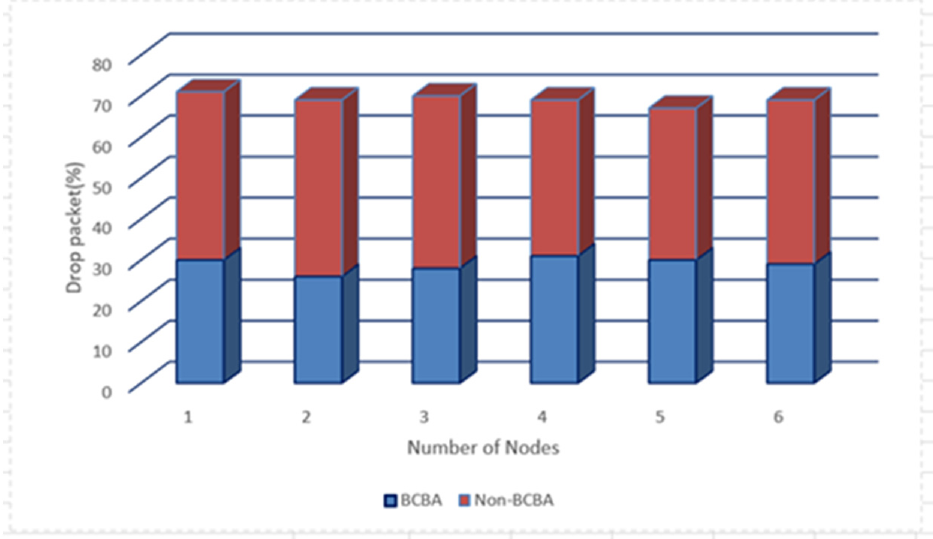
Figure 9. Packet drop scale in non-blockchain and blockchain-based techniques.